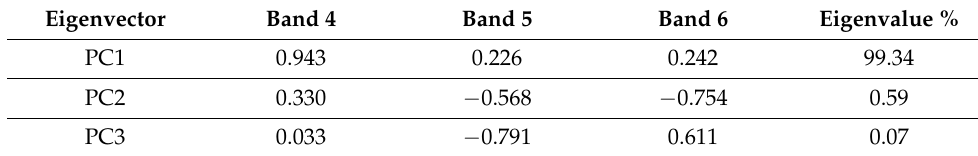
Table 3. PCA analysis of selected bands of ASTER